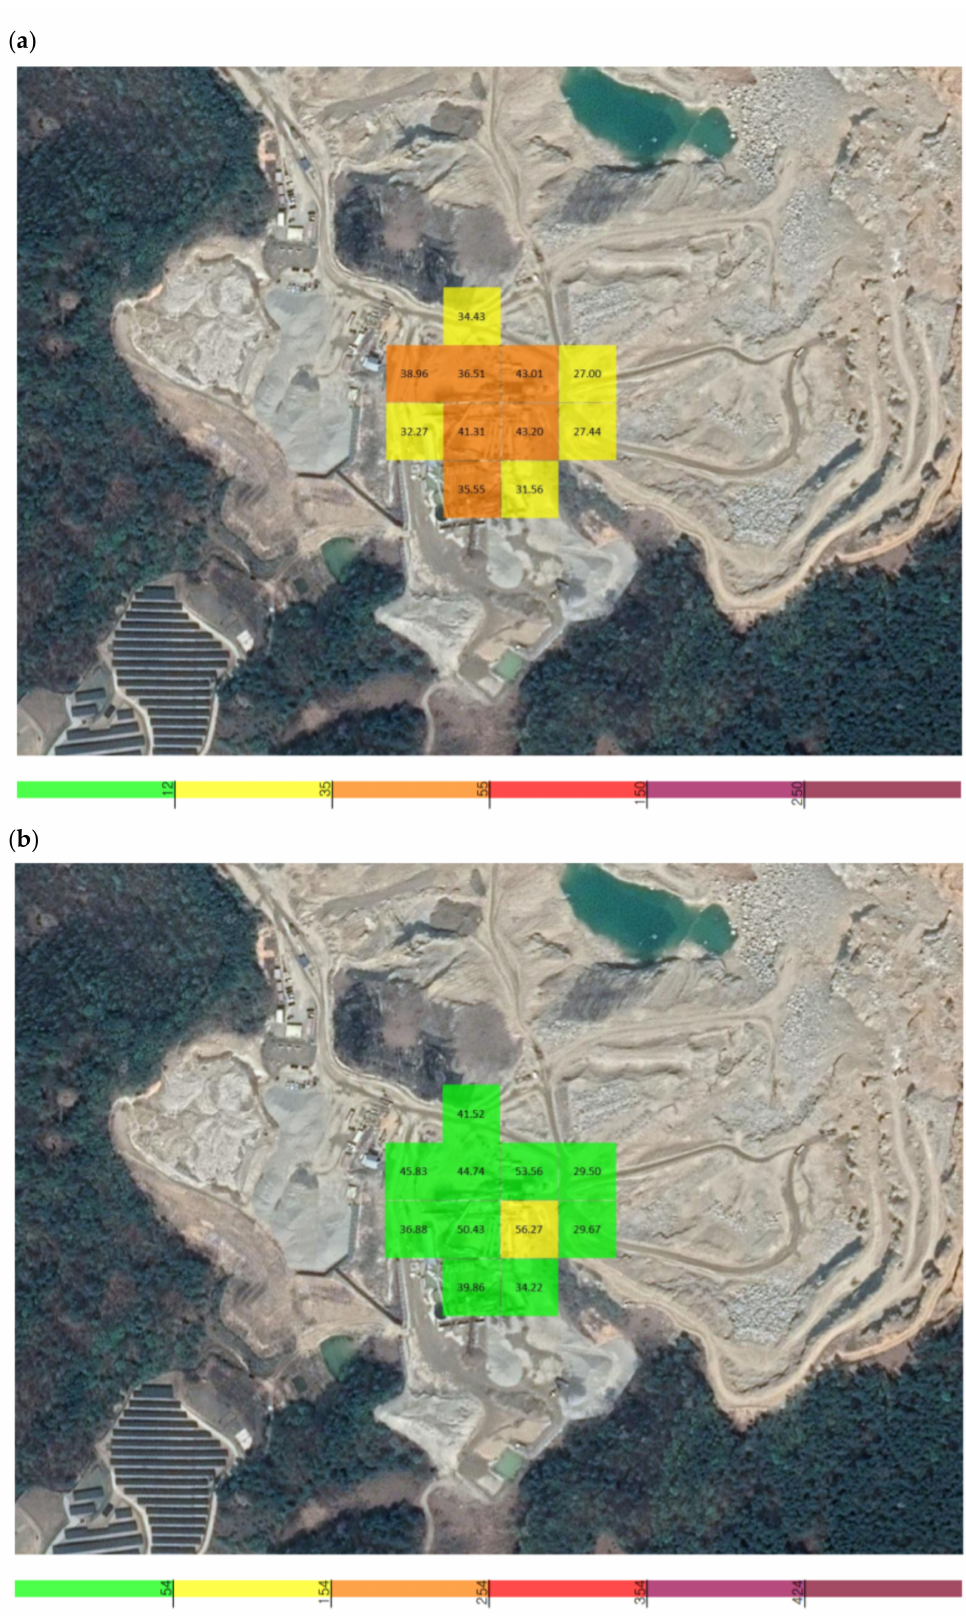
Figure 8. Grid detection area of the unmanned aerial vehicle (UAV) measuring sensor at Y